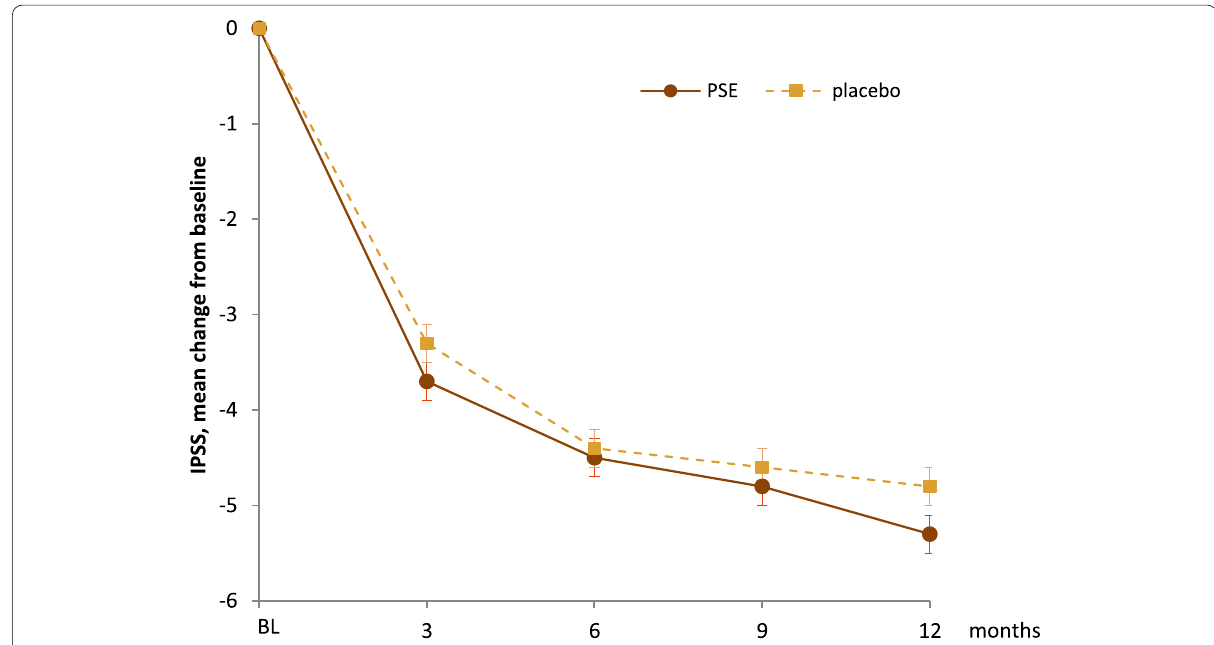
Fig. 2 Mean IPSS changes from baseline during 12-month treatment (ITT set). Vertical bars indicate standard error. PSE pumpkin seed soft extract; BL baseline